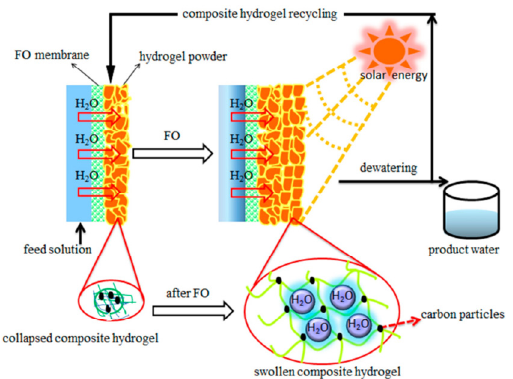
Figure 7. A description of employing solar energy for the recovery of thermos-responsive hydrogels draw solutions in the hydrogels-based FO system for desalination [103]. Image reused under the Creative Commons